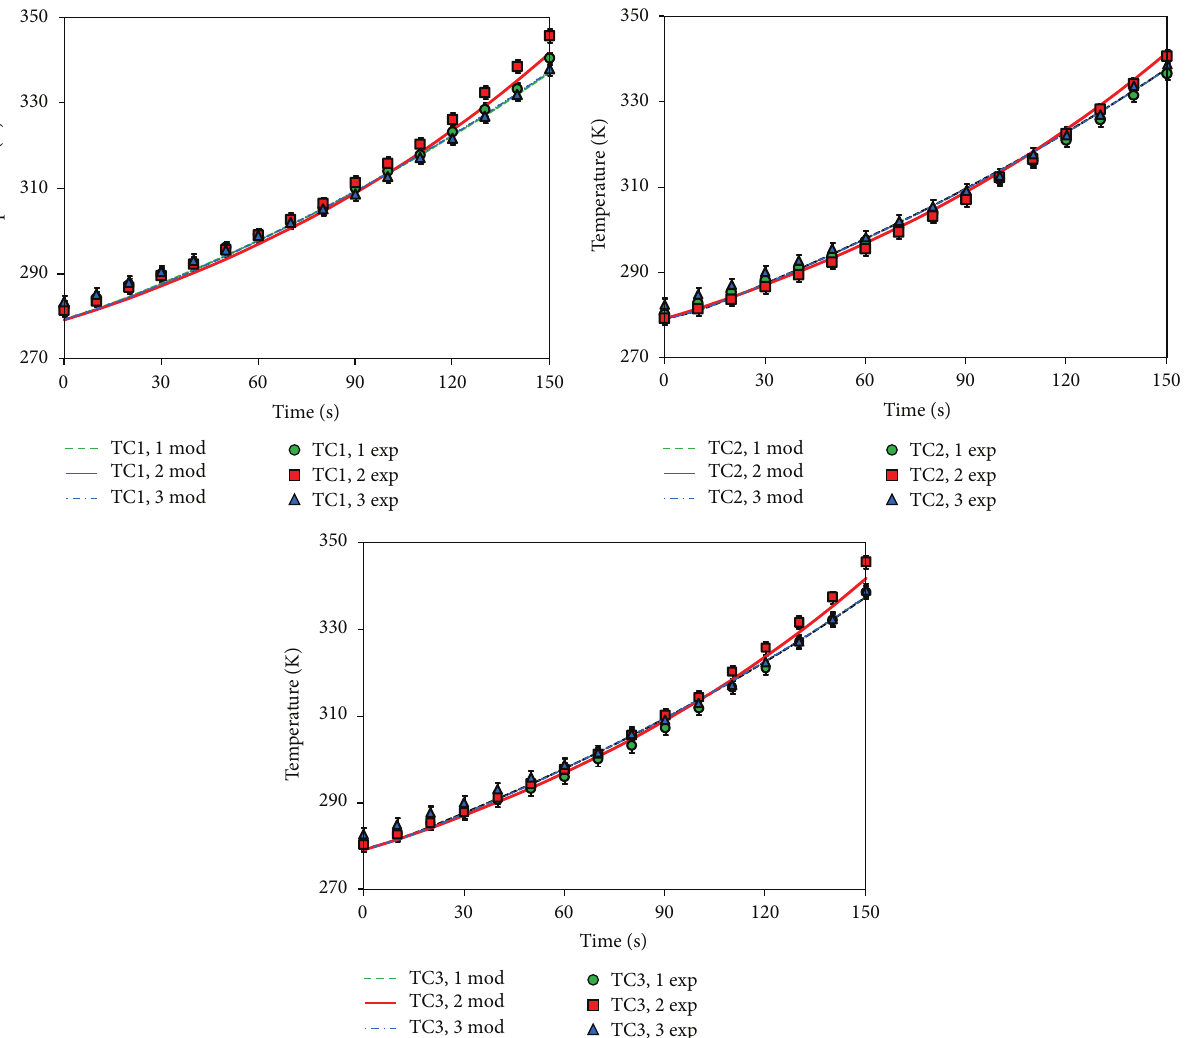
Figure 3: Comparison among experimental results (markers) and simulation results (lines) at 9 measurement points as in Figure 2. Total processing time: 150 seconds; applied voltage set point: 100V; 𝑇 0 = 279.15 K; 𝑈 = 5 Wm −2 K −1 ; 𝑇 inf = 286.15